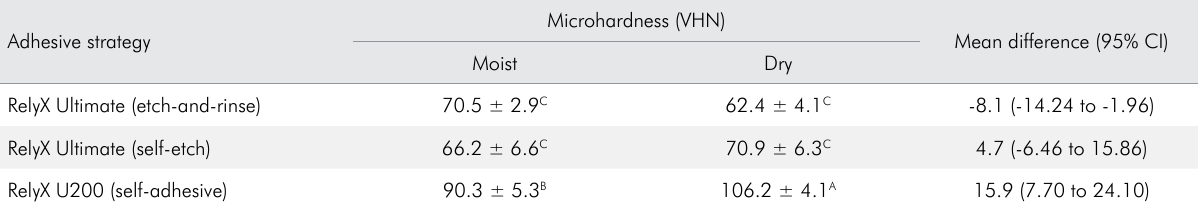
Table 3. Means, standard deviations, and mean differences for